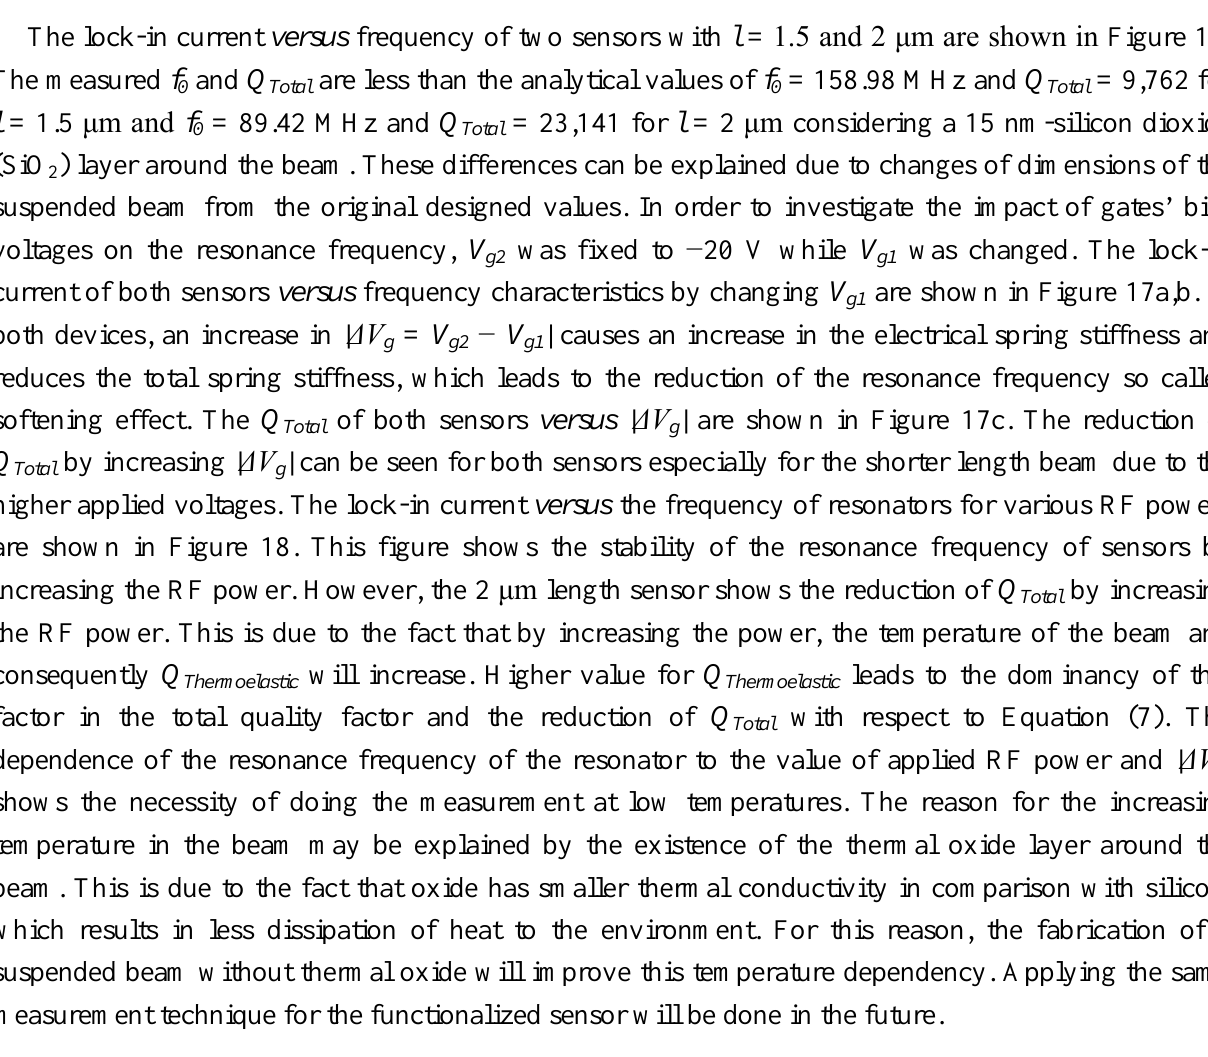
Figure 16. High frequency characteristics of in-plane resonant nano-electro-mechanical (IP R-NEM) sensors with different lengths of the suspended